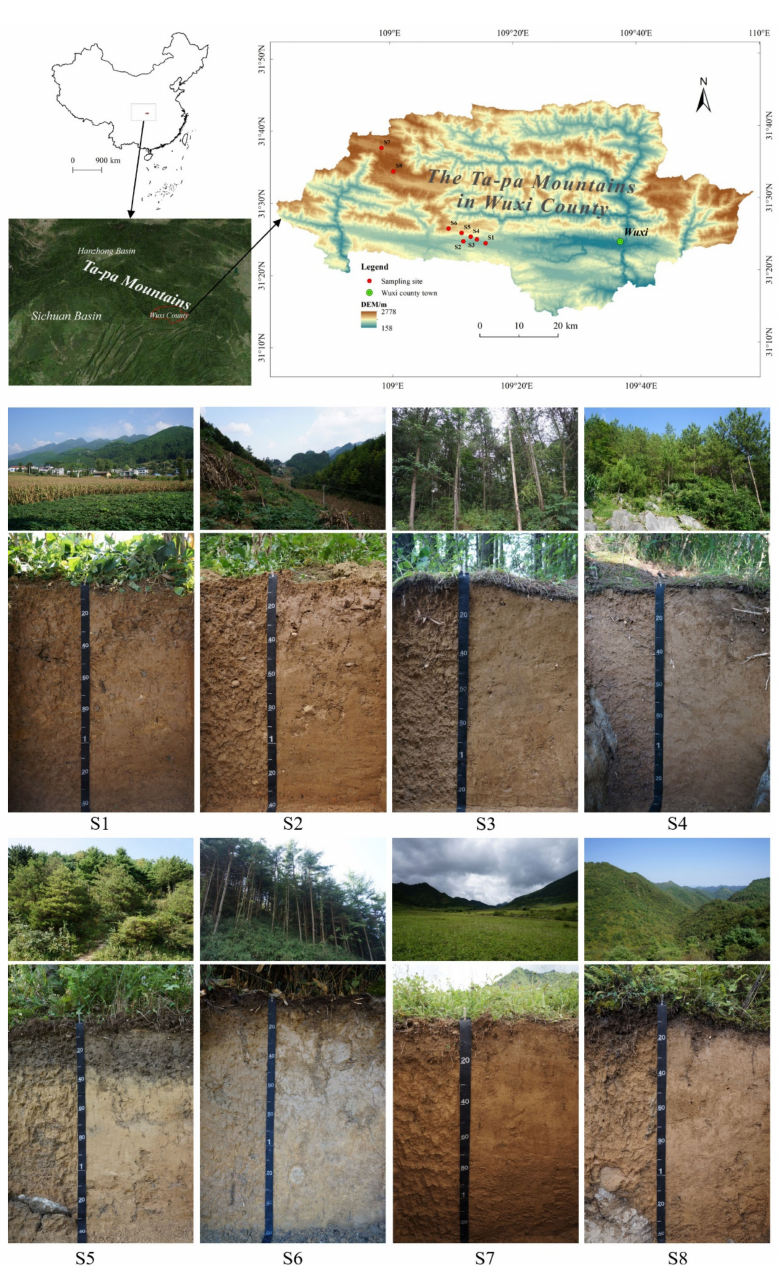
Figure 1. General position of the eight soil profiles in relation to China and pictures of the eight soil